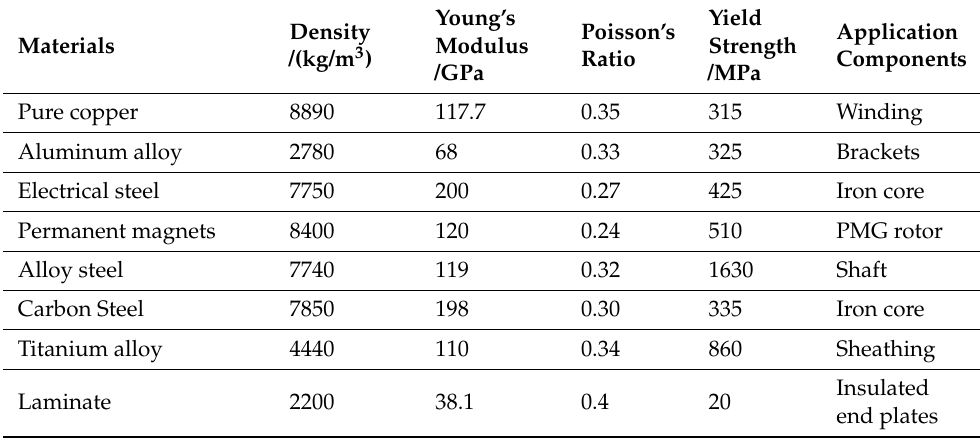
Table 9. Physical properties of the rotor materials.